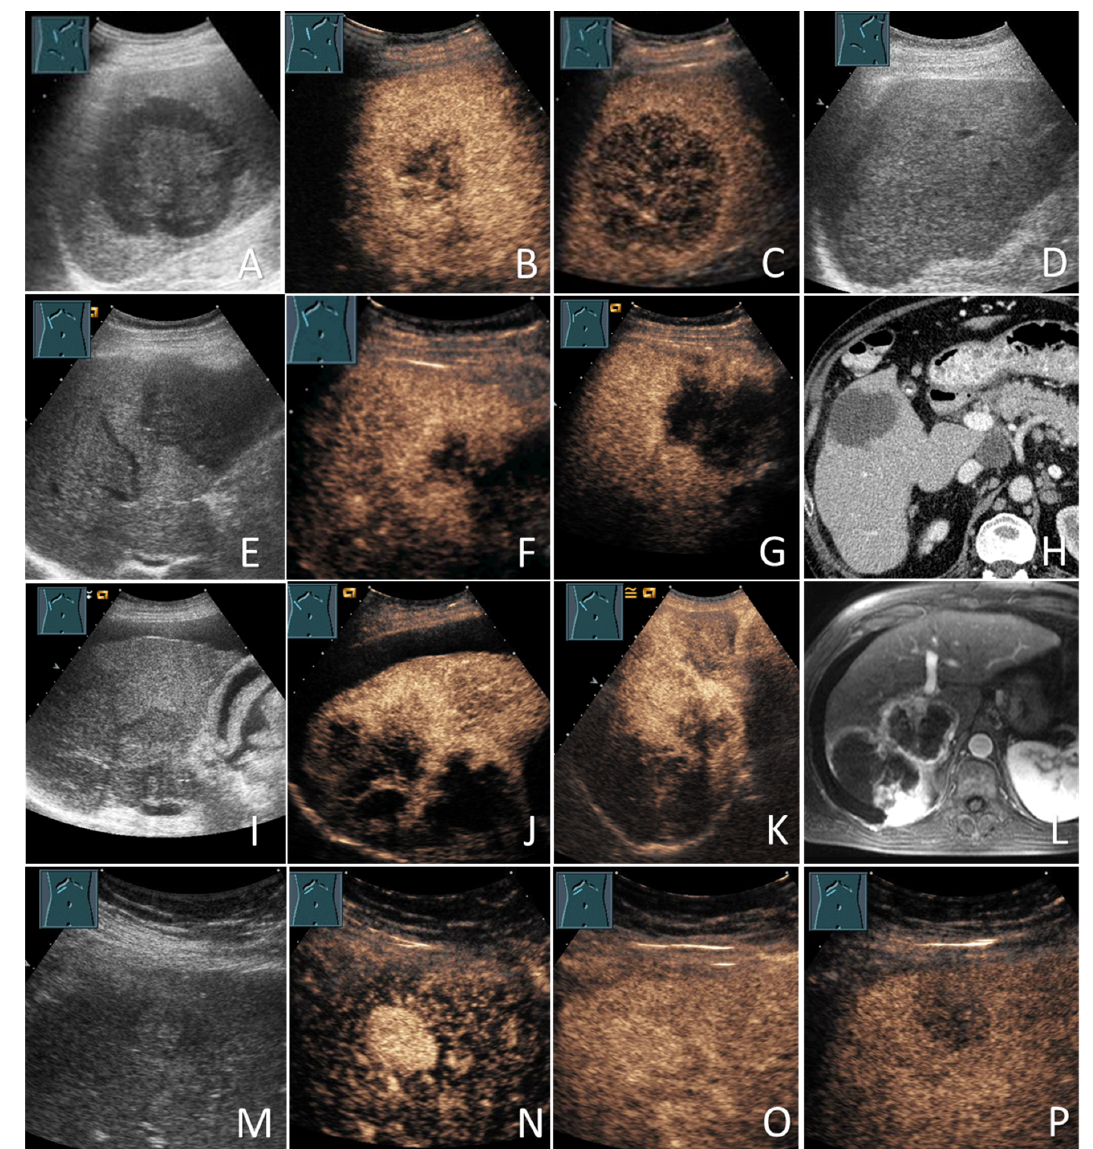
Figure 3. Malignant focal liver lesions (mFLLs) in patients with liver cirrhosis (LC). Lymphoma (the biopsy showed diffused large B-cell lymphoma) ( A – D ): large hypoechoic FLL on grey-scale ultrasound ( A ); large hypoechoic FLL with inhomogeneous enhancement on the arterial phase ( B ); large hypoechoic FLL with marked washout in the delayed venous phase ( C ); the sonographic follow-up image with the near total resolution of the lesions after chemotherapy ( D ). Metastases (the biopsy showed an adenocarcinoma and the primary tumor was unknown (CUP)) ( E–H ): hypoechoic FLL on grey-scale ultrasound ( E ); hypoechoic FLL with inhomogeneous peripheral isoenhancement on the arterial phase ( F ); hypoechoic FLL with early washout within 2 min ( G ); the corresponding CT of the FLL (courtesy of Prof. Dr. Andreas H. Mahnken, Department of Radiology, University Hospital Marburg) ( H ). Cholangiocarcinoma (the biopsy showed an intrahepatic cholangiocarcinoma) ( I–L ): large lobulated hypoechoic lesion on grey-scale ultrasound ( I ); large lobulated hypoechoic lesion with inhomogeneous peripheral enhancement after 20 s ( J ) and 60 s ( K ); the corresponding MRI of the FLL (courtesy of Prof. Dr. Andreas H. Mahnken, Department of Radiology, University Hospital Marburg) ( L ). Hepatocellular carcinomas (the lesions were proved to be moderately differentiated HCC on the histology) ( M–P ): small echogenic lesion on grey-scale ultrasound ( M ); small echogenic lesion with an early arterial phase hyperenhancement after 12 s ( N ) small echogenic lesion with isoenhancement after 40 s ( O ); small echogenic lesion washout after 3 min ( P